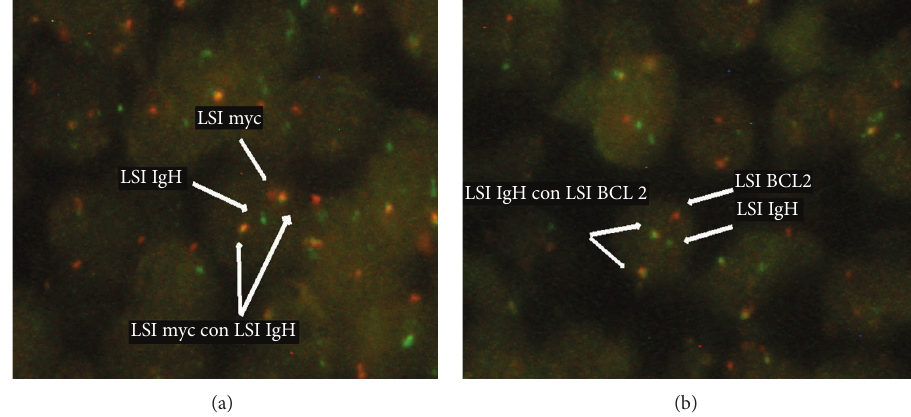
Figure 4: FISH analysis using Abbott Tri-color Dual fusion Translocation Probe hybridized to a nucleus revealing, (a) an IgH/c- myc rearrangement by the juxtaposition of the red (c-myc) and green (IgH) yielding the yellow fusion. One native c-myc (red) and native IgH (green) are also present; (b) a BCL-2 / IgH rearrangement by the juxtaposition of the red ( BCL-2 ) and green ( IgH ) yielding the yellow fusion. One native BCL-2 (red) and native IgH (green) are also present.